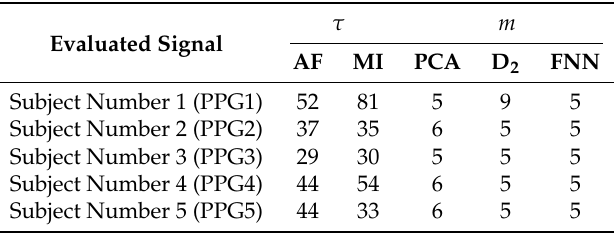
Table 1. Parameters τ and m of the PPG signals, acquired from five individuals chosen at random, for the different methods already explained, namely autocorrelation function (AF), mutual information (MI), principal component analysis (PCA), correlation dimension ( D 2 ), and false nearest neighbors (FNN). The parameters are calculated for all the subjects of the experimental research (40 PPG signals), proving that with the FNN method, all of them showed m = 5. τ m Evaluated Signal AF MI PCA D 2 FNN Subject Number 1 (PPG1) 52 81 5 9 5 Subject Number 2 (PPG2)